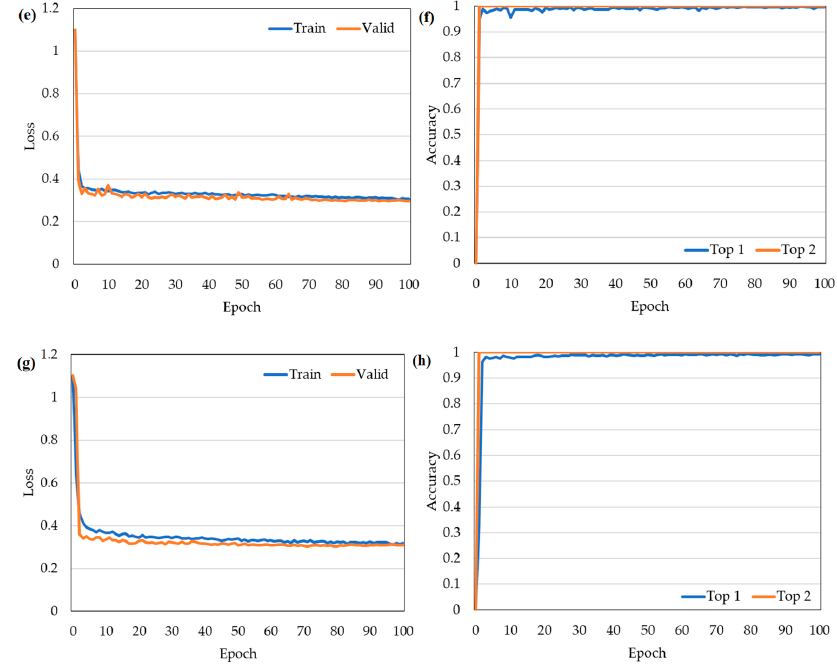
Figure 1. Training loss ( left ) and accuracy ( right ) of the four models: ( a ) and ( b ) Yolov5m; ( c ) and ( d ) ResNet-50; ( e ) and ( f ) ResNet-101; and ( g , h ) EfficientNet-B0. Table 1. Training model parameters and evaluation results of the four models . Model